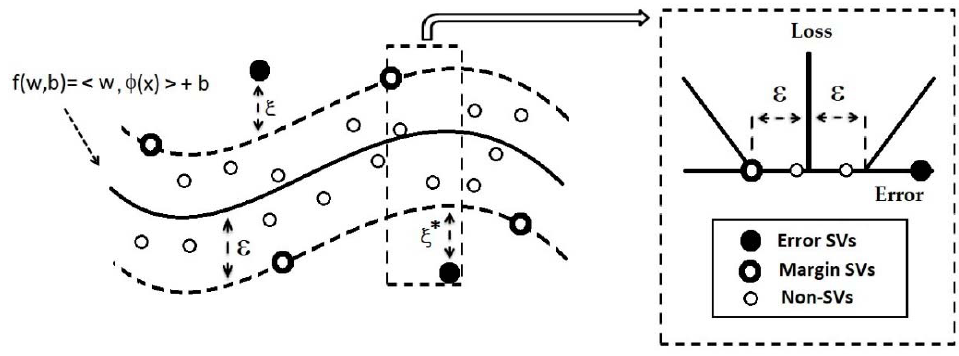
Figure 4. Nonlinear support vector regression (SVR) with Vapnik’s ε -insensitive loss function. The selection of an appropriate transformation 𝜙(cid:4666)𝒙(cid:4667) is not an easy task. However, one advantage of SVR is that, in practice, the nonlinear function 𝜙(cid:4666)𝒙(cid:4667) does not need to be used.